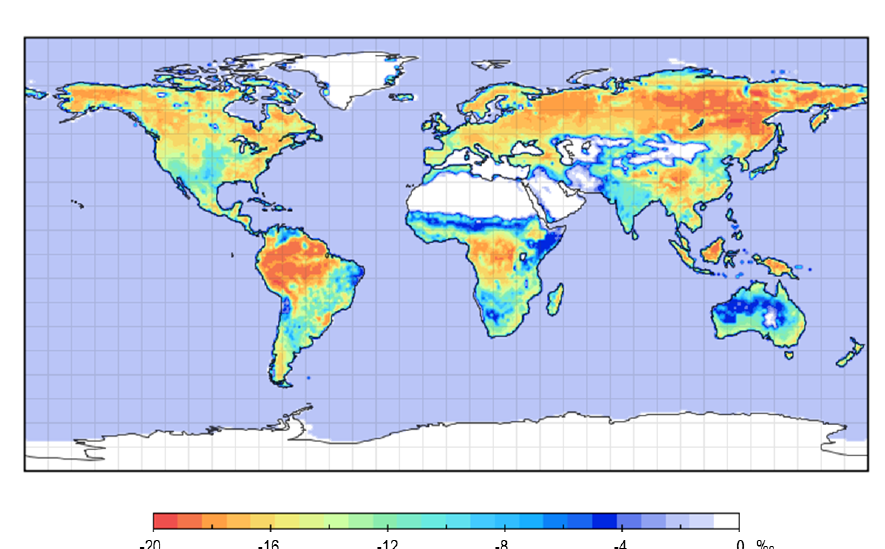
Figure 3. The annual mean of the total photosynthetic 13 C discrimination ( (cid:49) in Eq. 7) in 2003.